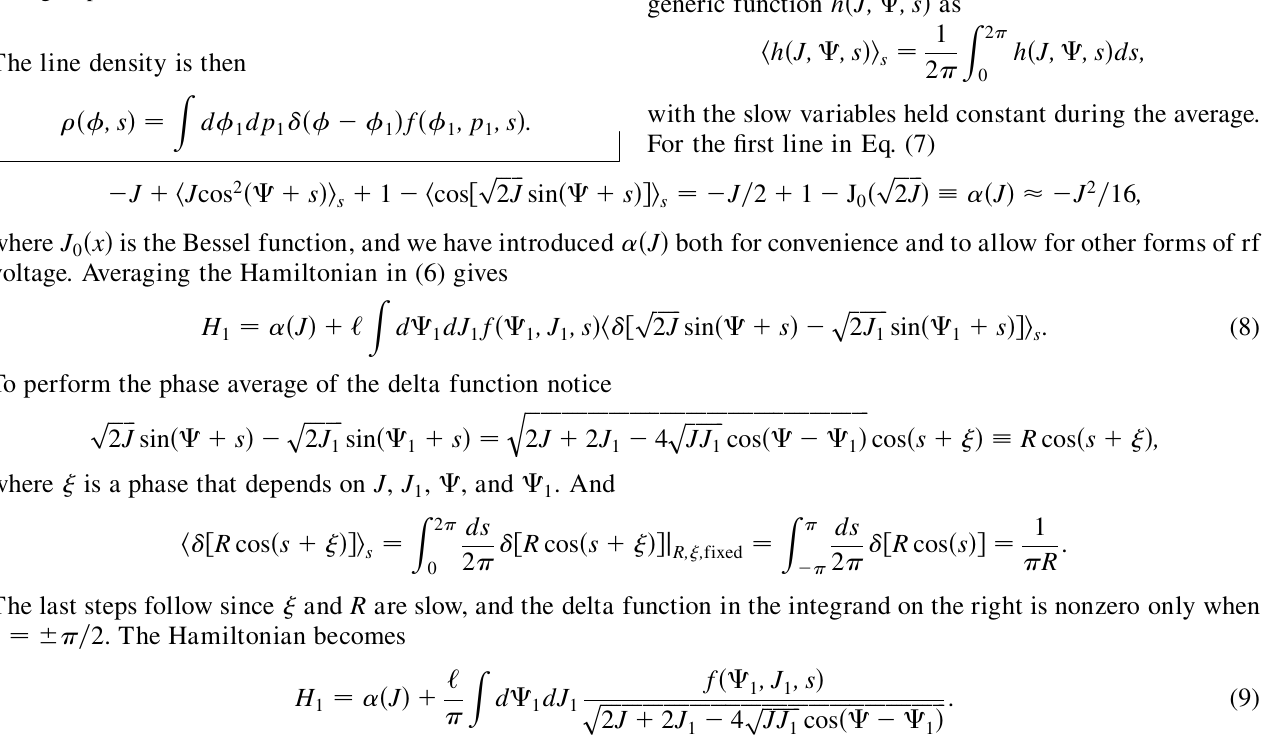
FIG. 6. Scatter plots of p versus (cid:3) from longitudinal simu- lations with a sinusoidal rf voltage and a broadband impedance. The initial conditions (top panels) are identical and the only difference during the evolution is the sign of the broadband impedance. Effects of a defocusing impedance are shown on the left and those for a focusing impedance are shown on the right. Plots at 400 synchrotron periods (middle panels) and 800 synchrotron periods (bottom panels) clearly show that a defo- cusing impedance can lead to